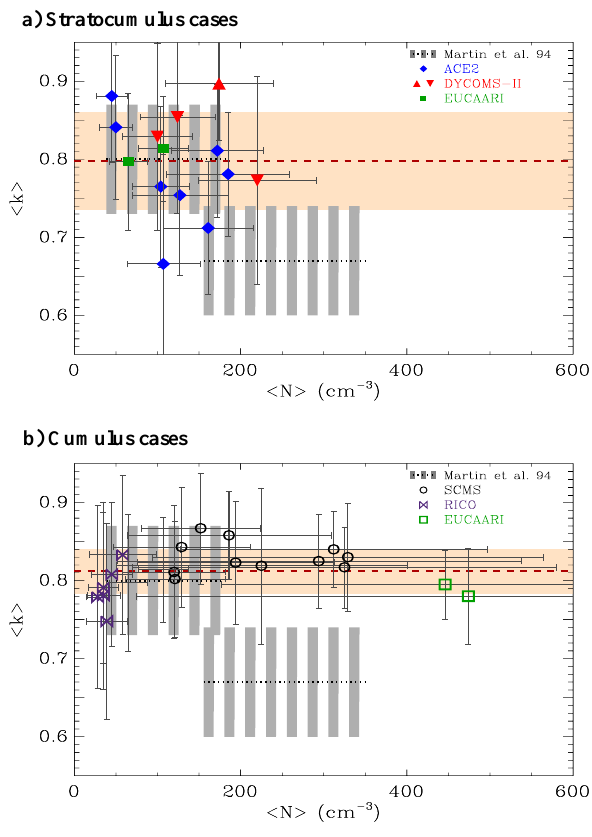
Fig. 6. Flight averaged k factor as function of mean total droplet number concentration for the cases studies listed in Table 4, Sc clouds in (a) and Cu clouds in (b) . The error bar corresponds to one standard deviation. The average of all the cases in each figure is indicated with a dashed line and a light orange bar for the stan- dard deviation. The two dotted lines with grey bars apart are the values recommended by Martin et al.